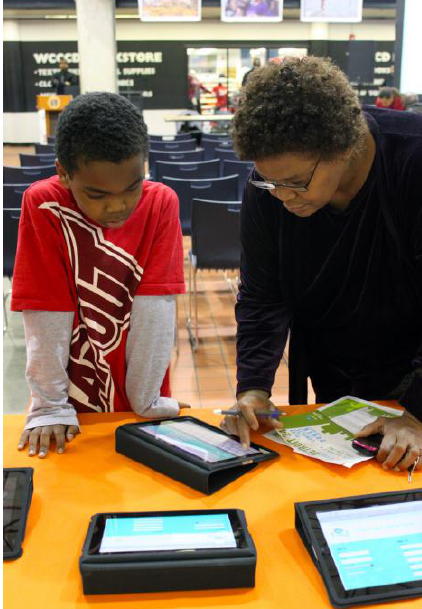
Figure 6. A high percentage of young people between the ages of 10 to 24 participated in the project’s online planning game “Detroit 24/7”. (Photo credit: Detroit Collaborative Design